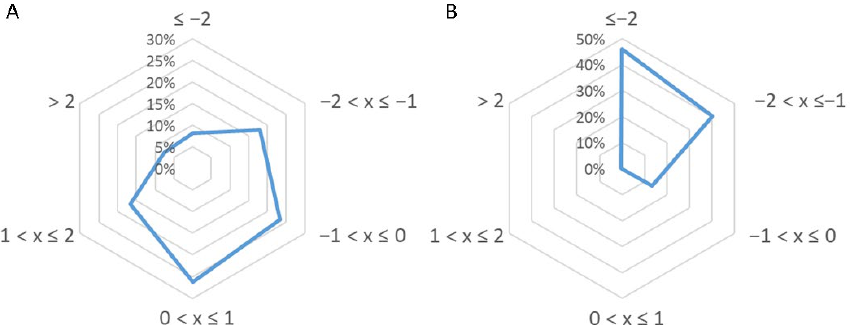
Figure 4. Gravy index score distribution for ( A ) short peptides and ( B ) medium-sized peptides identified in fractions 2 and 3 of soybean hydrolysate.